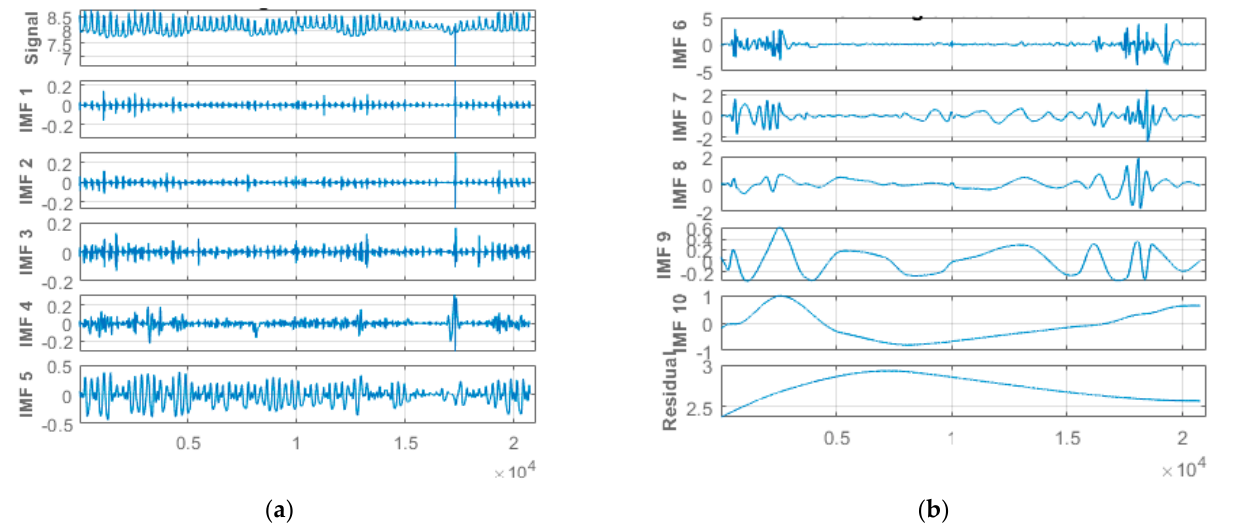
Figure 9. ( a ) One to five of 10 different IMFs for the water pH data signal. ( b ) Six to ten of 10 different IMFs and the corresponding residual for the water pH data signal.